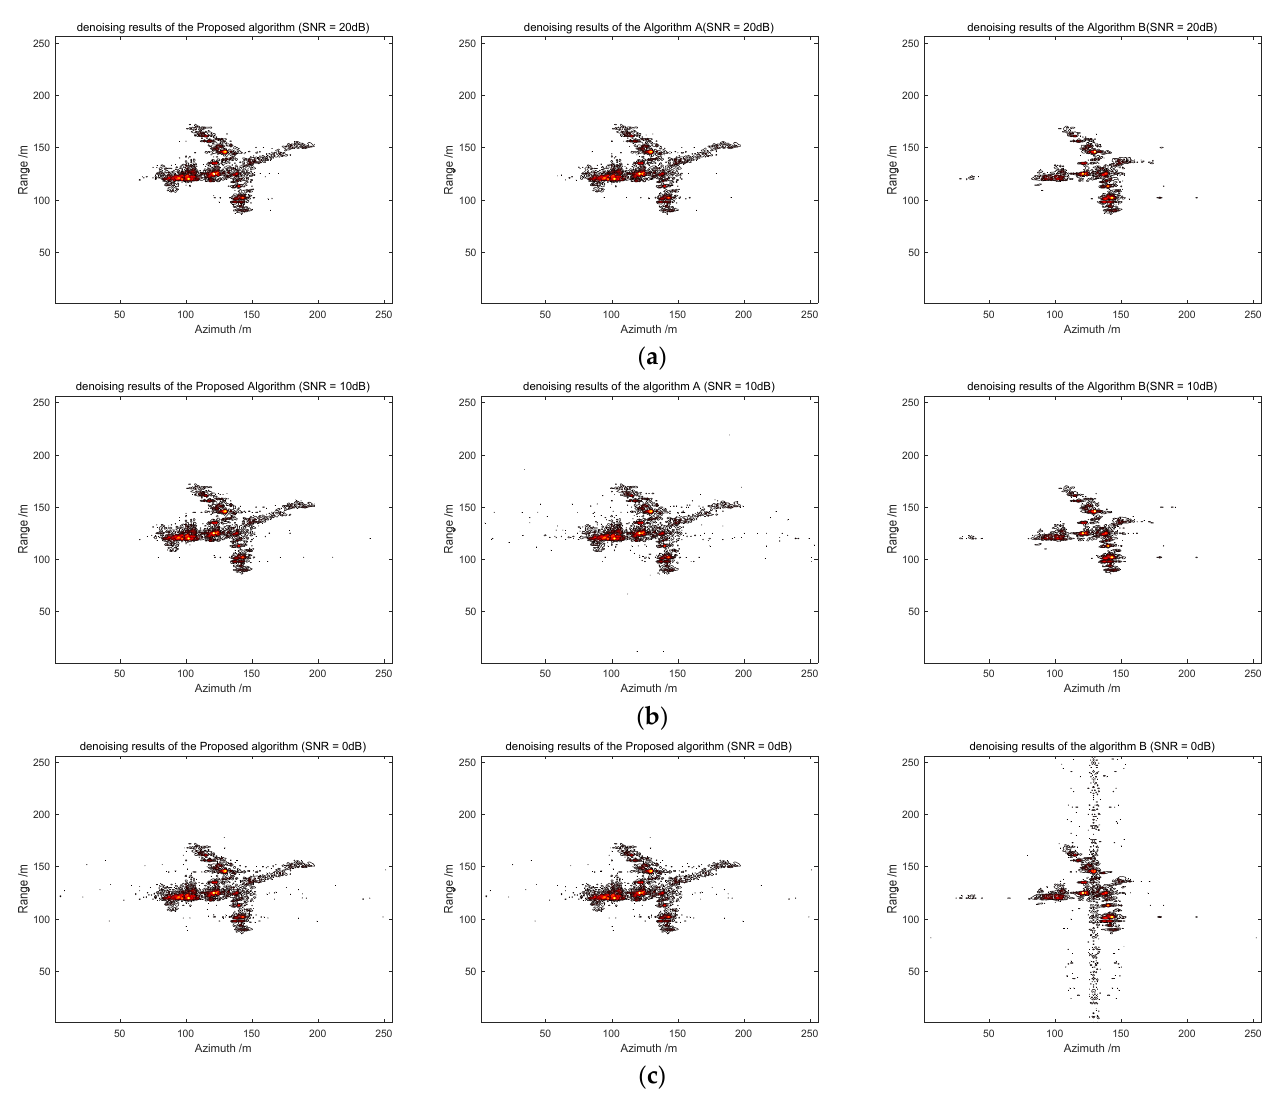
Figure 7. Simulation results 2: ( a ) imaging results under SNR = 0 dB; ( b ) imaging results under SNR = 0 dB; and ( c ) imaging results under SNR = 0 dB. Table 3. Experimental Results under different SNRs of measured data.